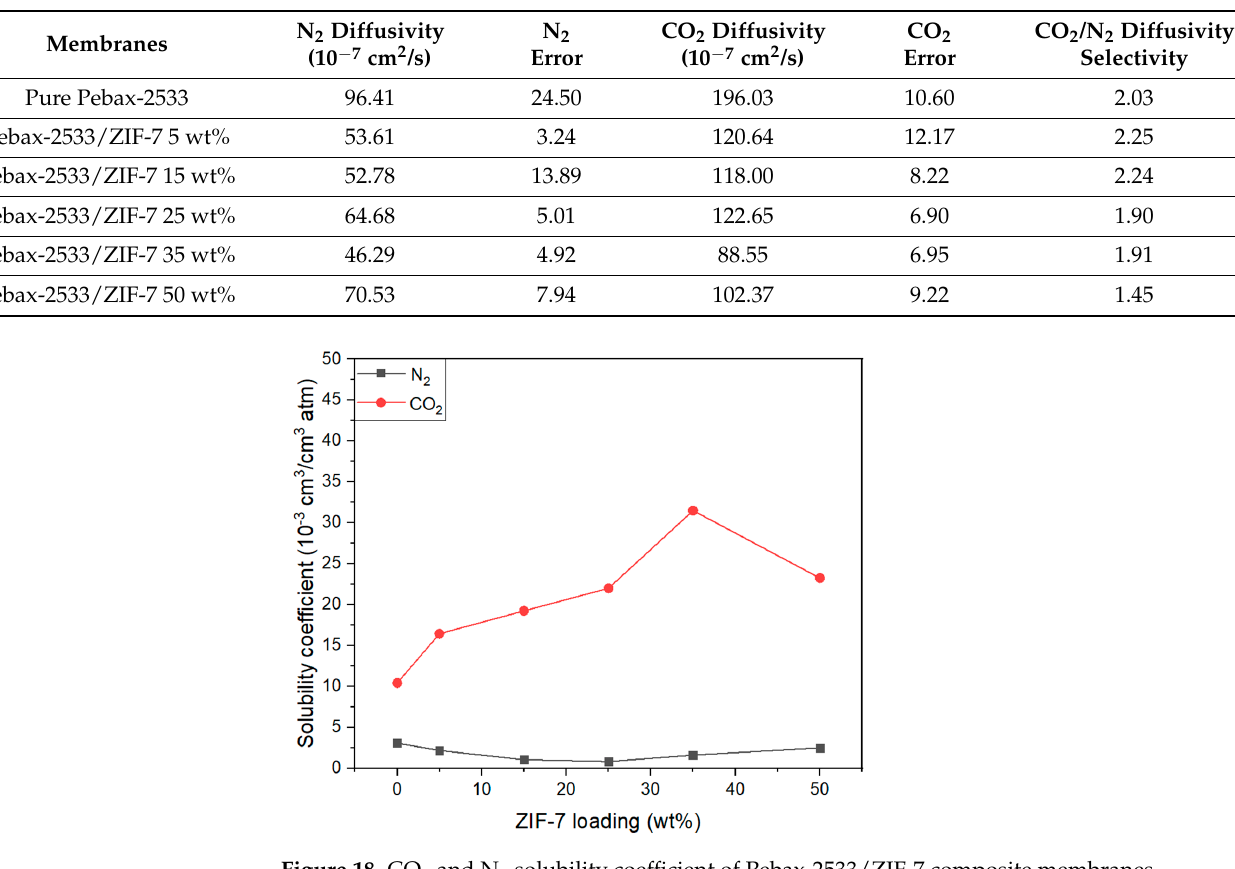
Table 6. Gas diffusivity properties of Pebax-2533/ZIF-7 composite membranes.